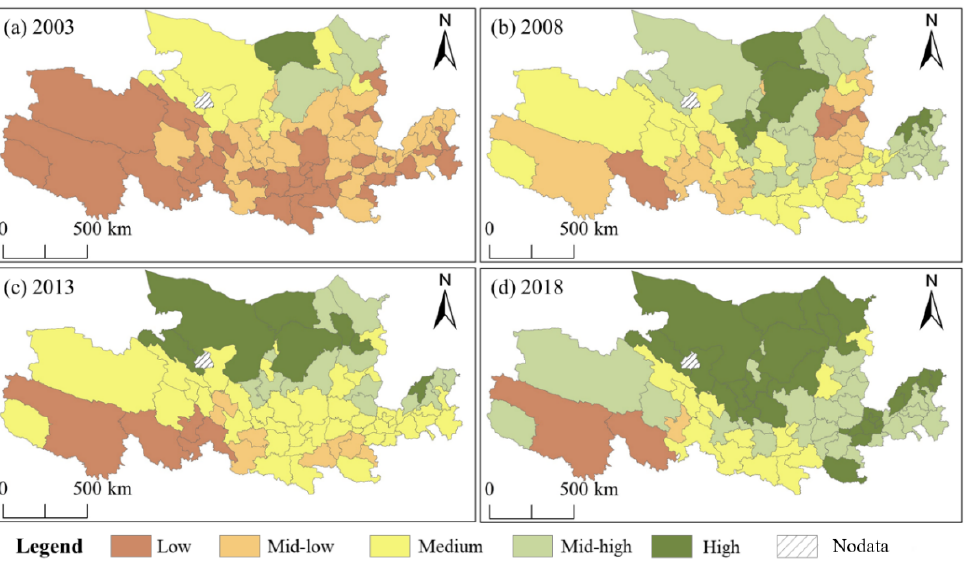
Figure 4. Spatio-temporal pattern of FS in the YRB. ( a – d ) denote the spatio-temporal pattern of FS for 2003, 2008, 2013 and 2018, respectively.